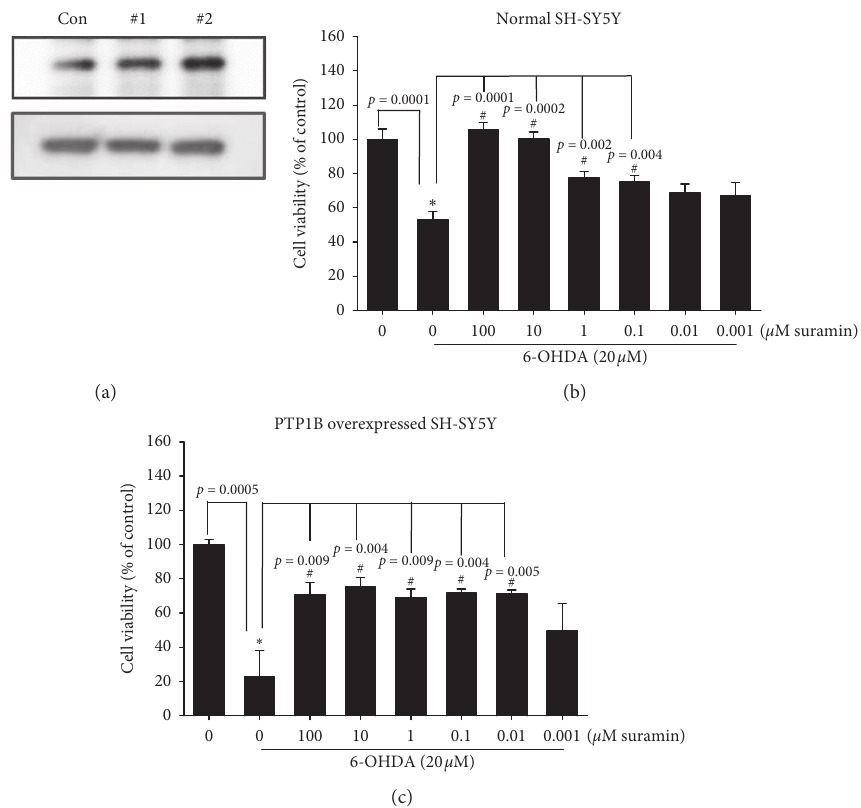
Figure 5: Effect of PTP1B overexpression in SH-SY5Y on PTP1B expression and neuroprotective effect against 6-OHDA damage. (a) PTP1B-overexpressed SH-SY5Y was established by the transfection of PTP1B plasmid. Western blotting for PTP1B of the control, #1 PTP1B-overexpressed SH-SY5Y, and #2 PTP1B-overexpressed SH-SY5Y groups are shown. (b) Normal SH-SY5Y cells were pretreated with 0.01, 0.1, 1, and 10 μ M suramin for 1h and then challenged with 20 μ M 6-OHDA for 16h in the control, 6-OHDA, 6-OHDA plus suramin, and suramin alone groups. Data are presented as mean ± SEM, and each value contains three replicates and six samples. ∗ Significantly different from the 6-OHDA group. (c) PTP1B-overexpressed SH-SY5Y was established by the transfection of PTP1B plasmid. Cell viability of the control; 6-OHDA; and 6-OHDA plus 100, 10, 1, and 0.1 μ M suramin groups was measured. Data are presented as mean ± SEM, and each value contains three replicates and three samples. ∗ Significantly different from the control (negative control) group. # Significantly different from the 6-OHDA (negative control)